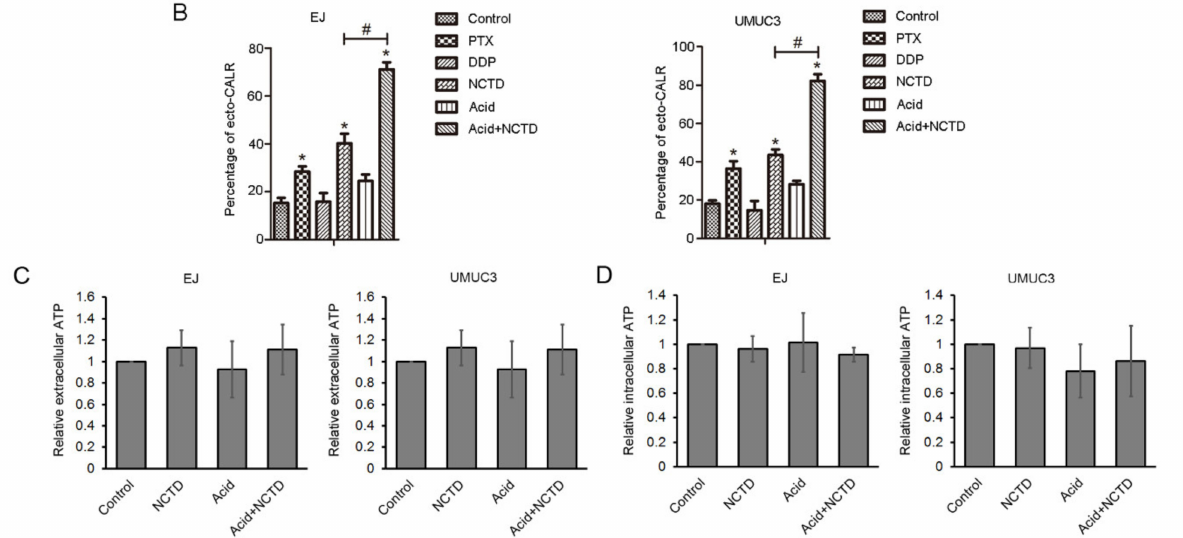
Figure 3. NCTD promotes calreticulin (CALR) surface exposure in bladder cancer cells. ( A ) Flow cytometry analysis of CALR on the cell surface of EJ and UMUC3 bladder cancer cells treated with NCTD for 3 days in physiological (12 µ M NCTD) and acidic culture medium (3 µ M NCTD). Paclitaxel (PTX) and Cisplatin (DDP) were used as positive and negative controls, respectively. ( B ) Quantification of the percentage of ecto-CALR. Data are presented as the mean ± SD ( n = 3), * p < 0.05 vs. the control group, # p < 0.05 vs. the NCTD group. Extracellular ( C ) and intracellular ATP levels ( D ) were analyzed, data are presented as relative ATP abundance to the control